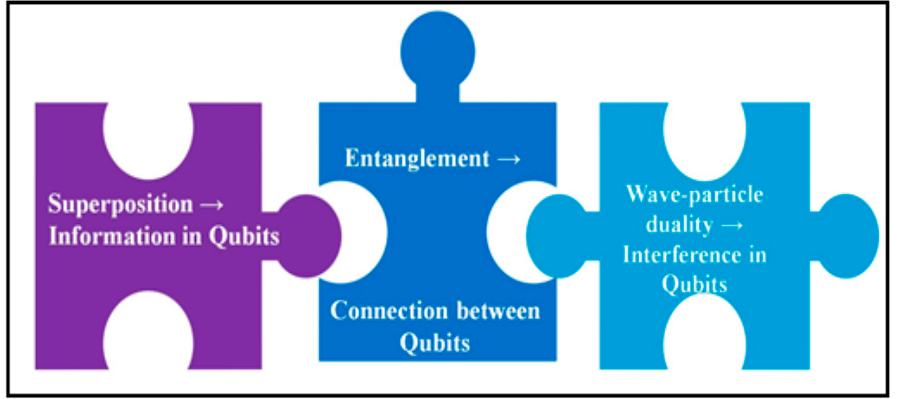
Figure 1. The figure shows the basic principles of qubits i.e., the superposition, entanglement and wave-particle duality. These principles contribute to achieving speedups in quantum computing.